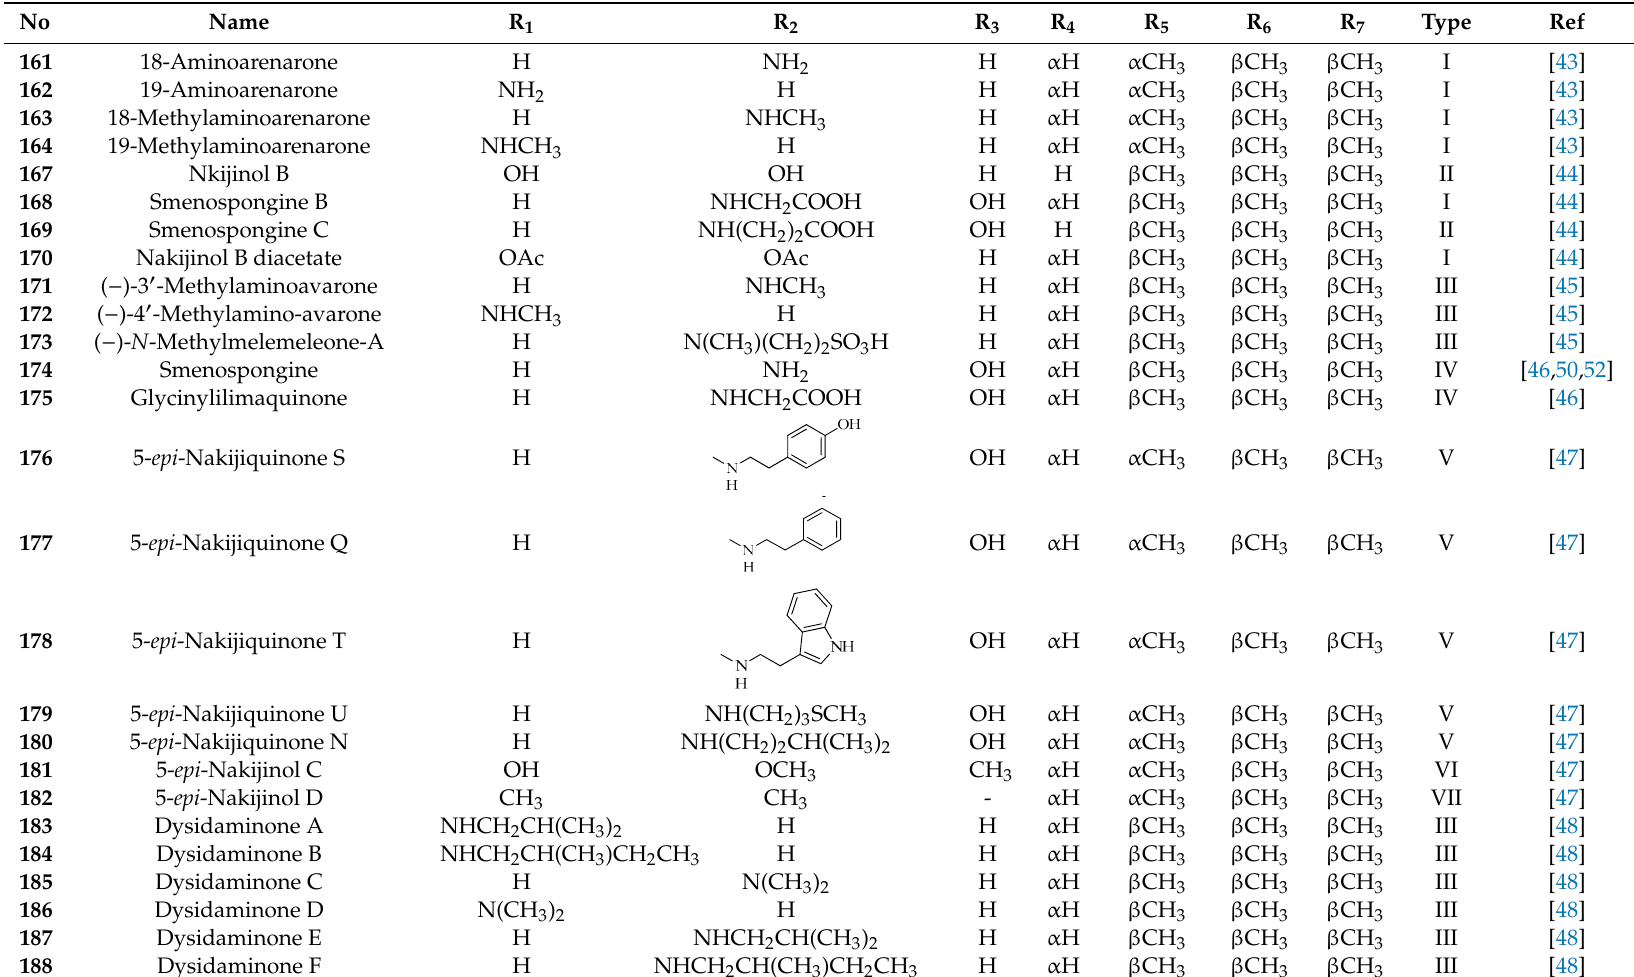
Table 2. Reported structures o ff riedo-drimane